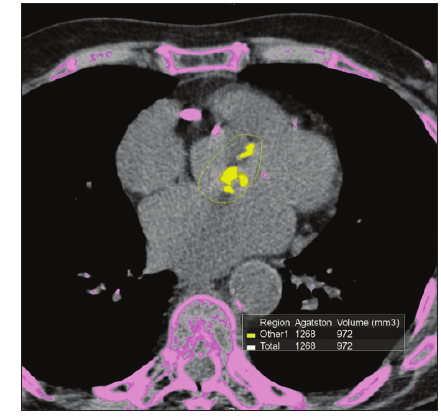
Figure 2. Multidetector computed tomography angiography scan of the aortic valve. The Agastston score is obtained by using the same imaging procedure and post-processing software as used for coronary artery calcium scoring. In this case, the AV Agastston score is represented by region Other1, which is also the total score. Care must be taken to avoid including the mitral annular calcification and aortic root calcification that is commonly associated with AV calcification.